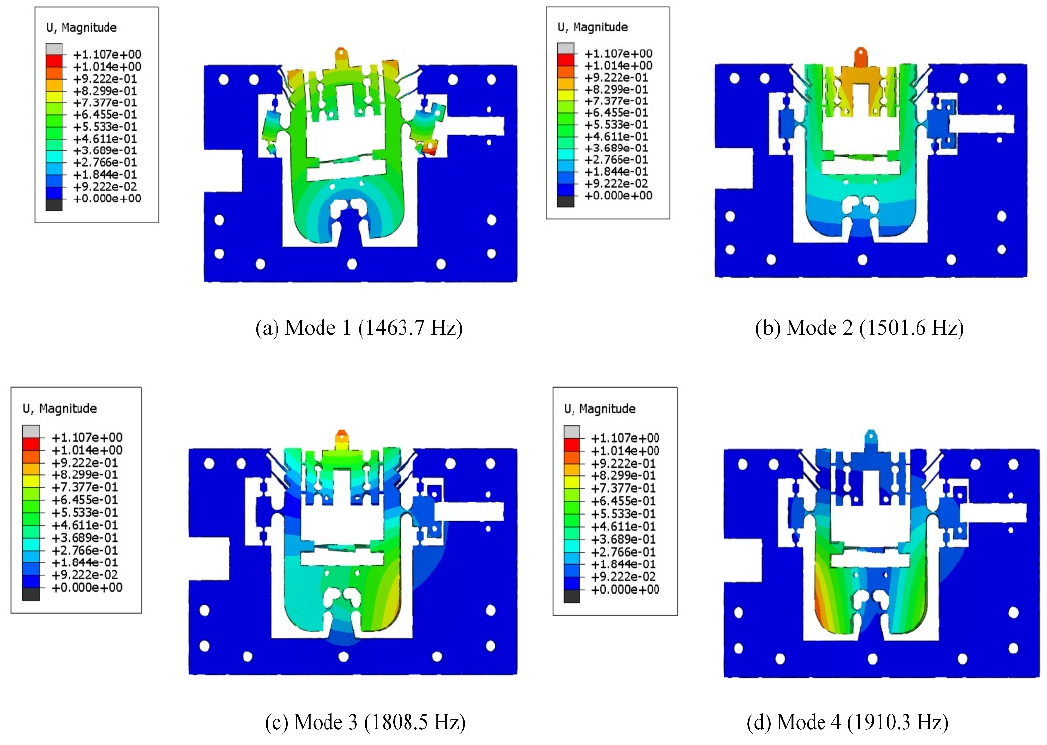
Figure 12. The first four modes of the mechanism.